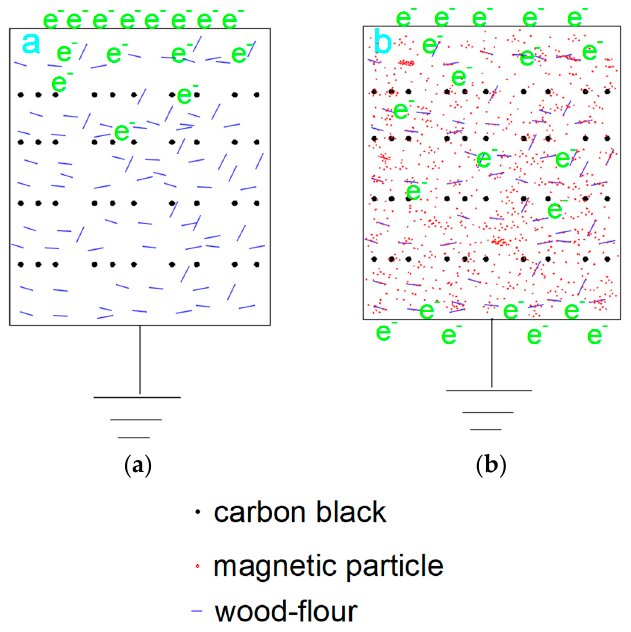
Figure 9. Assumed model of the synergistic effect of carbon black and magnetic lignocellulosic particles on electrical conductivity: ( a ) original biocomposites; ( b ) magnetic biocomposites.